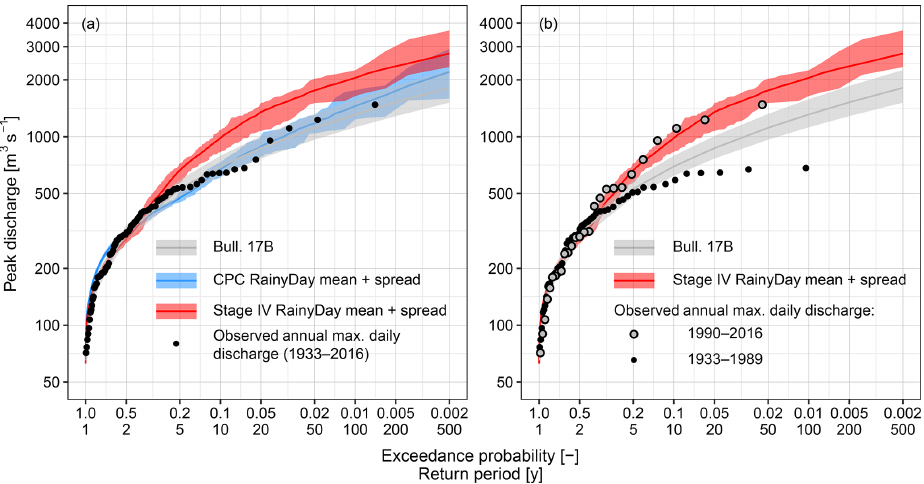
Figure 6. Peak discharge analyses for the Turkey River at Garber, IA. (a) RainyDay with Stage IV (2002–2016) and CPC (1948–2016) rainfall and USGS frequency analyses using Bulletin 17B methods. All observed USGS annual maximum daily streamflows from 1933 to 2016 are also shown. Shaded areas denote the ensemble spread (RainyDay-based results) and the 90% confidence intervals (Bulletin 17B- based analysis), respectively. (b) Same as (a) , but with the USGS observations divided into pre-1990 and post-1990 groups, and replotted to highlight recent changes in flood frequency.